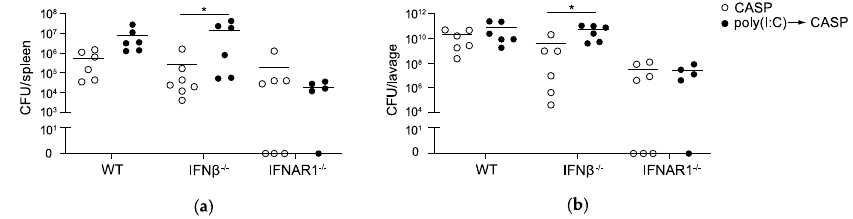
Figure 2. Increase in the bacterial load early during CASP after poly(I:C) pre-treatment in IFN β